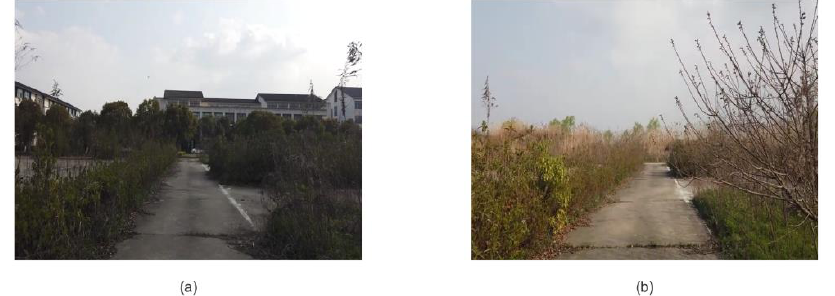
Figure 14. The image frame at the connected interface of the second scene. ( a ) Image frame obtained at one road connection. ( b ) Image frame obtained at another road